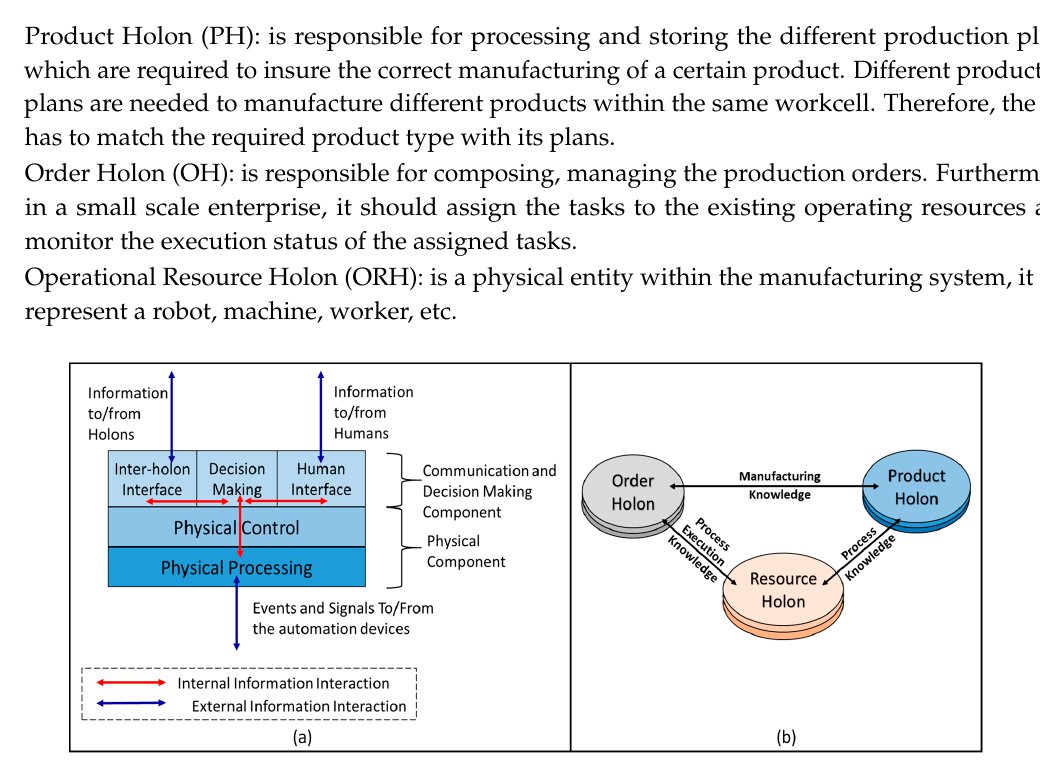
Figure 7. (a) Holon Generic Anatomy; (b) Product-Resource-Order-Staff-Architecture (PROSA) Model Holarchy. Model